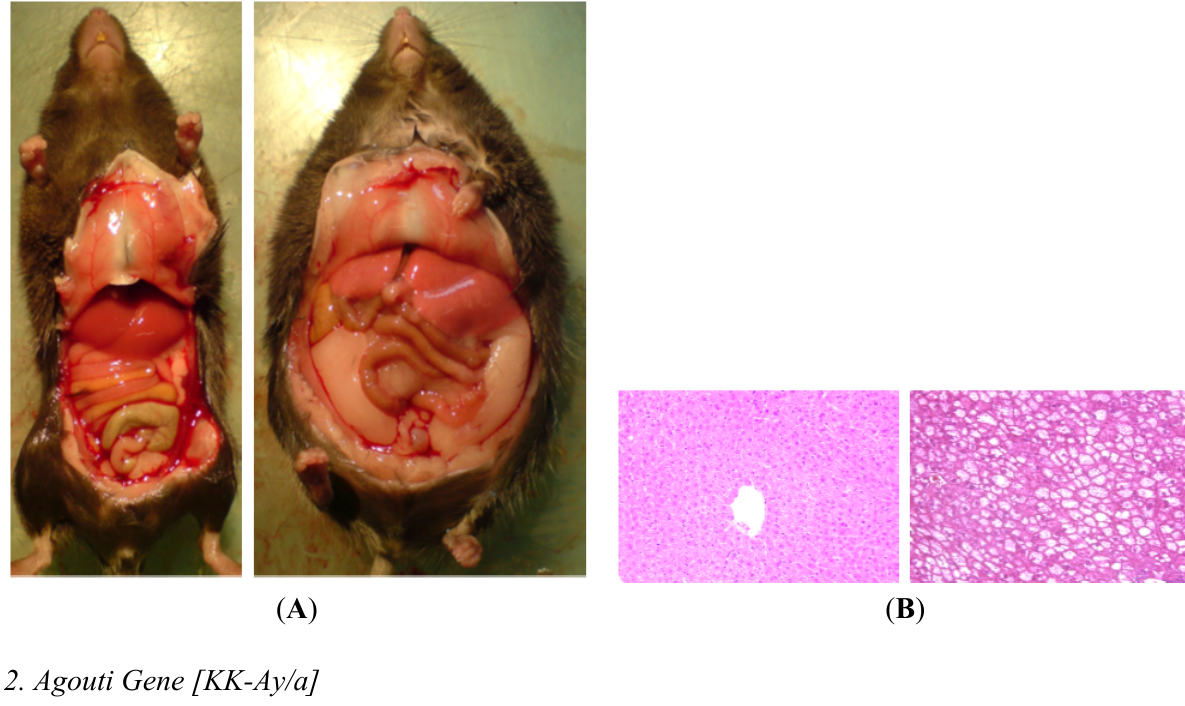
Figure 2. ( A ) Representative photographs of a lean (C57BL/6) and an ob/ob mouse, as well as ( B ) representative photomicrographs of liver sections stained with hematoxylin and eosin